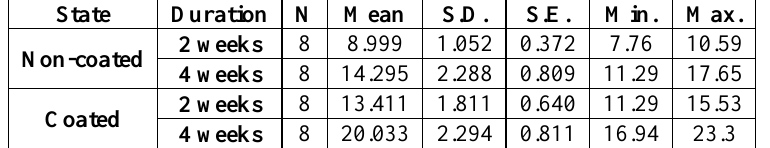
Table 1: Comparison of mean of torque value of coated and non coated group between 2 and